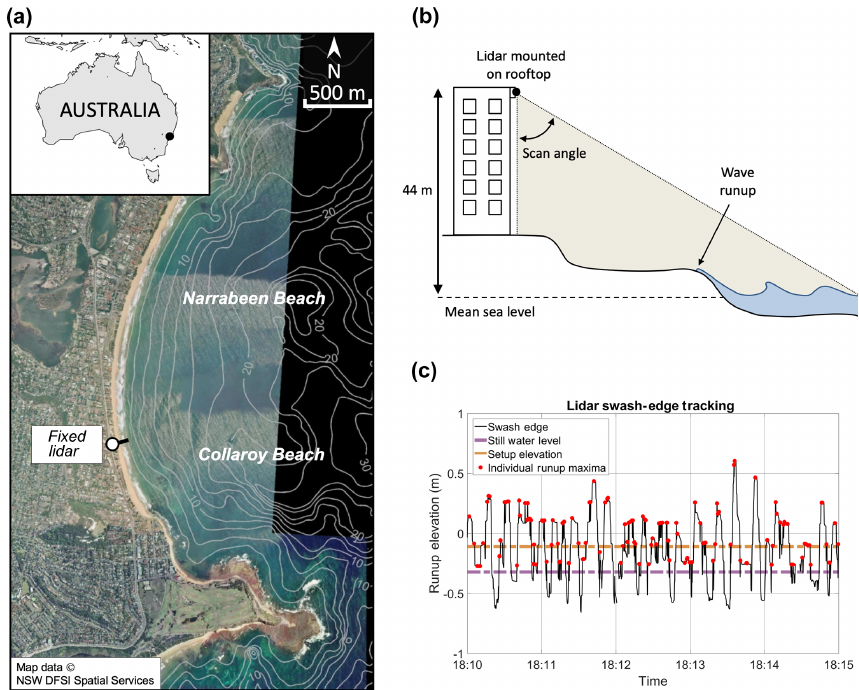
Figure 2. (a) Narrabeen Beach, located on the southeast coast of Australia. (b) Conceptual figure of the fixed lidar setup. (c) A 5min extract of runup elevation extracted from the lidar data; individual runup maxima are marked with red circles.